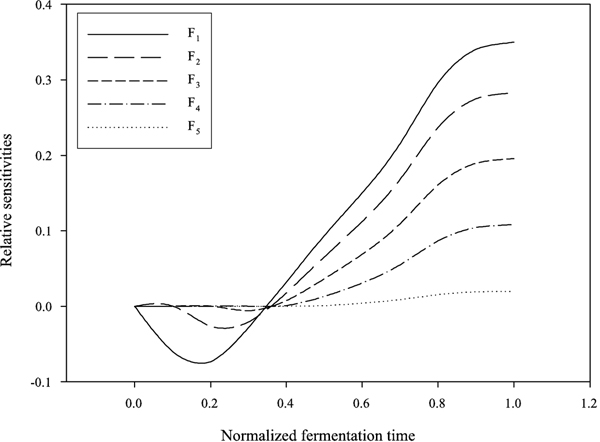
Dynamic log gains of J w.r.t. F(t). The dynamic log gains of ethanol production rate with respect to F
i
, i = 1,..., 5. The horizontal scale is in normalized fermentation time (t/t
f
).